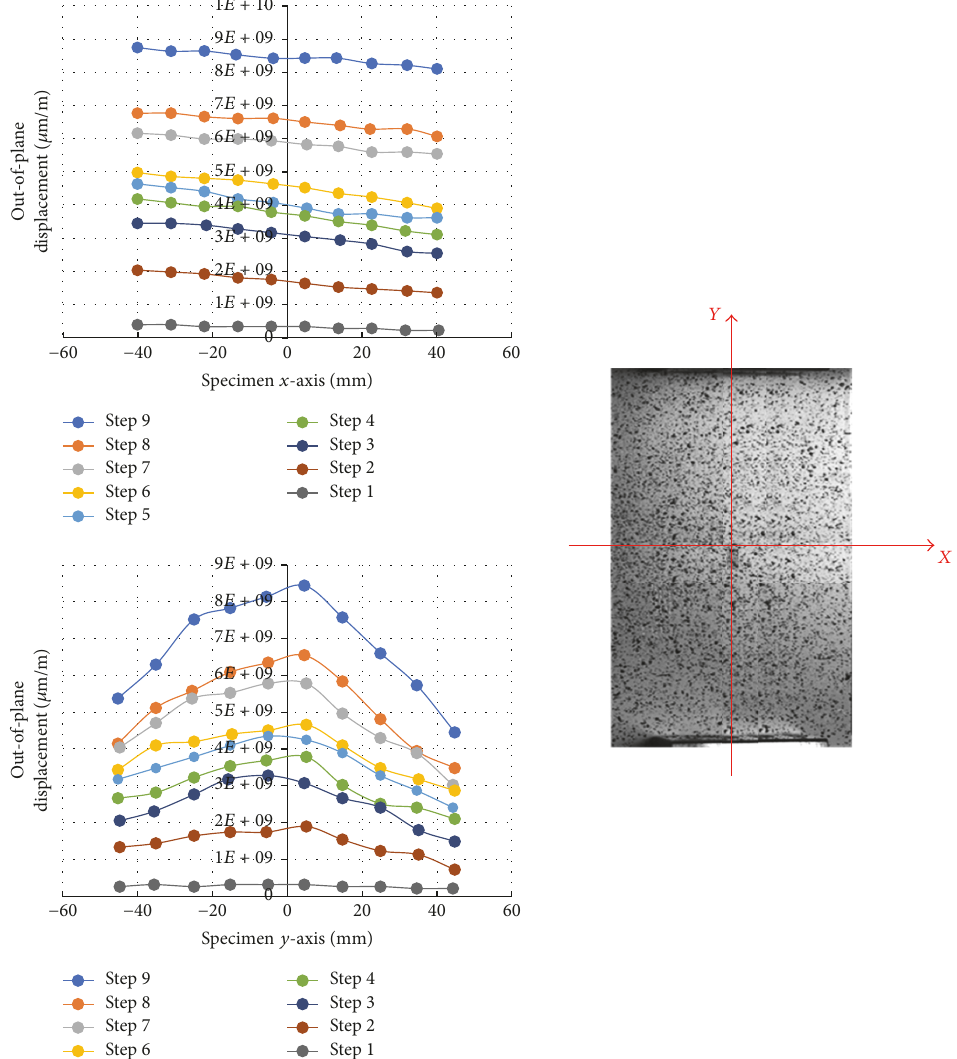
Figure 17: Out-of-plane displacement values along symmetry axes-side delamination